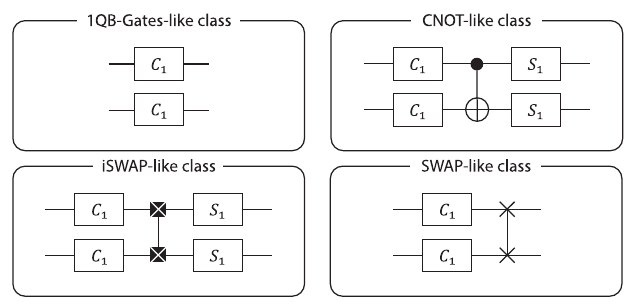
FIG. 25. Two-qubit Clifford classes.